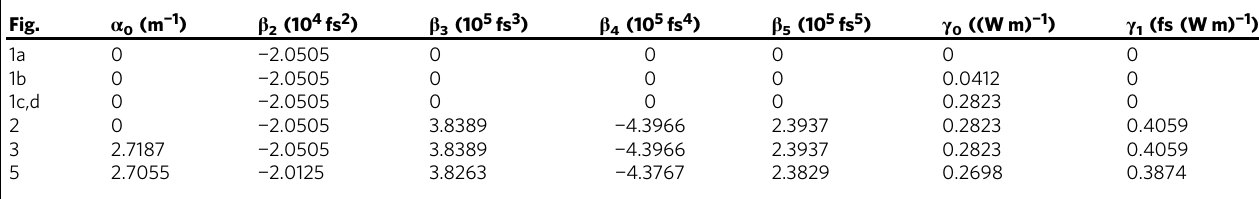
Table 1 Simulation parameters. Best approximation of the broadband fi bre parameters (at λ p = 1.95 μ m) used in the simulations of this paper